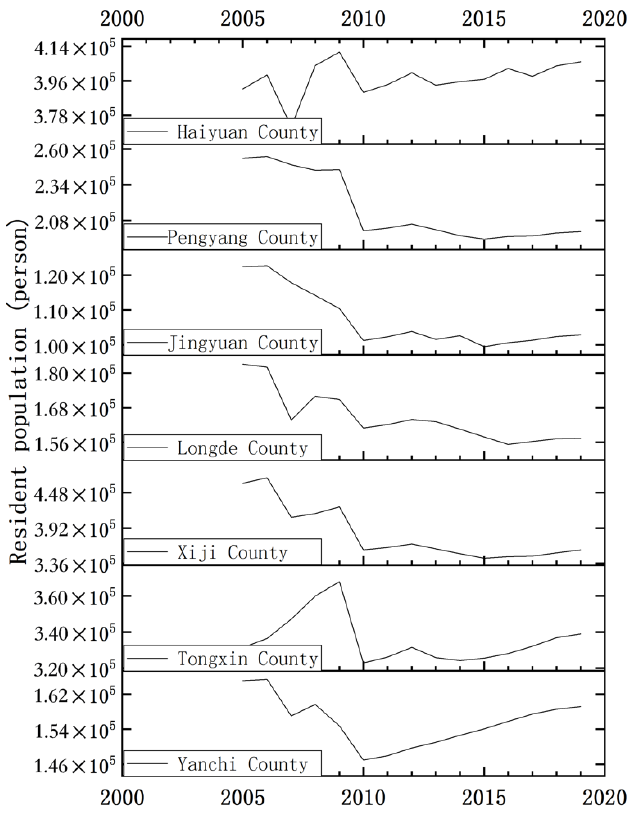
Figure 4. Chart of changes in resident population of each county in the study area from 2005 to 2019. Table 5. Population situation of each county in the study area from 2009 to 2018.